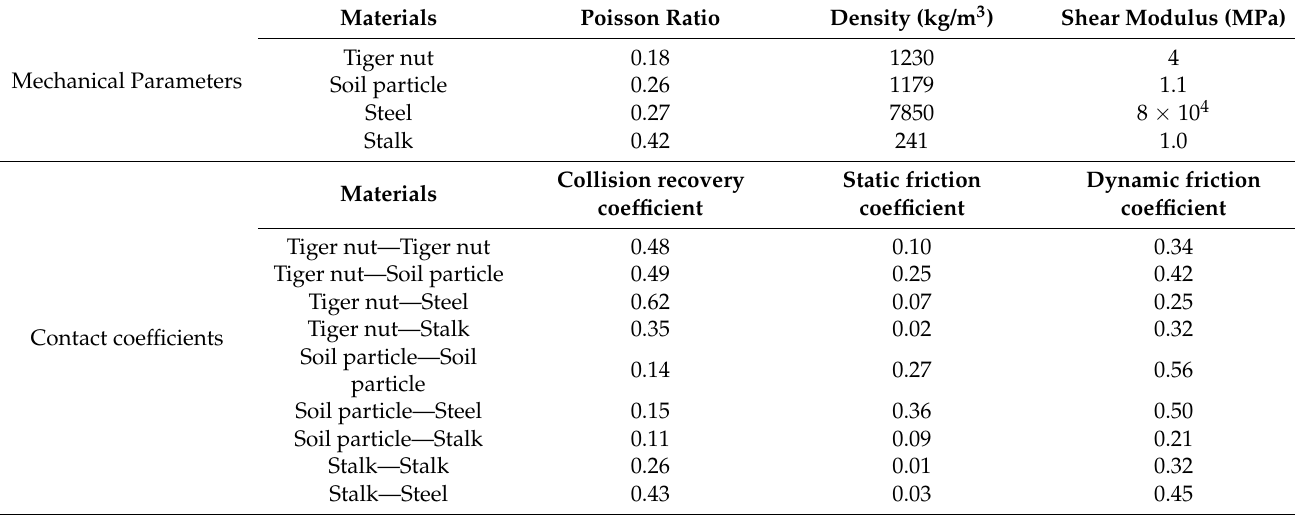
Table 1. Mechanical parameters and contact coefficients of materials.